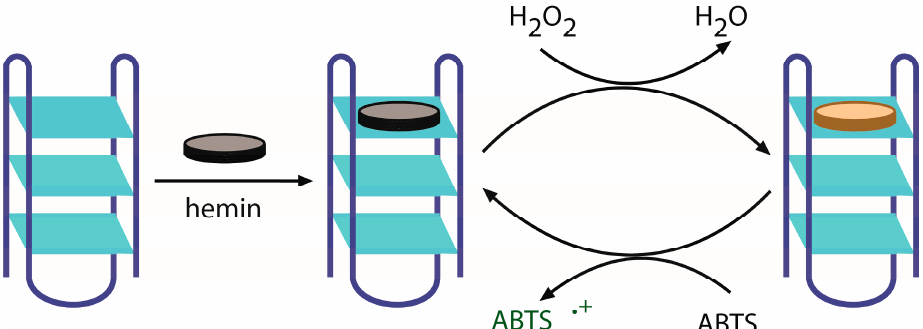
Figure 1. Assembly of G-quadruplex-hemin DNAzymes and H 2 O 2 -activated oxidation of ABTS. Guanine-rich DNA oligonucleotides fold to form G-quartet interactions (blue planes) which bind to hemin (grey discs). The resulting DNAzyme complex activates H 2 O 2 to oxidise a donor substrate (in this instance ABTS) using a mechanism similar to haem peroxidase-catalysed reactions. The reduced haem (brown disc) can react with H 2 O 2 and initiate another round of ABTS oxidation. The reaction product (ABTS • ) has a bright green colour with absorption maximum around 412–422 nm.